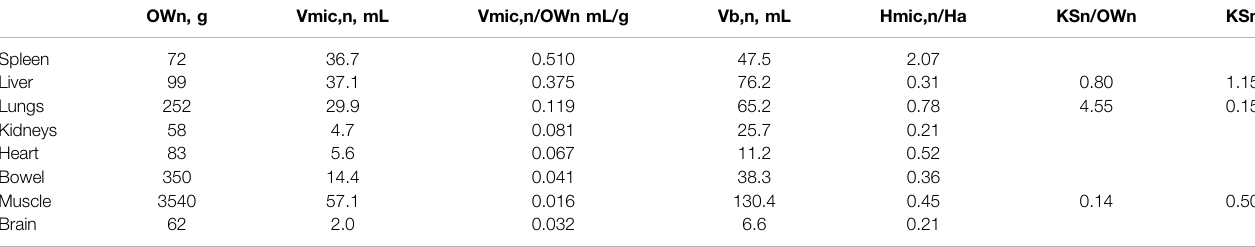
TABLE 2 | Organ weights, volumes of minute vessels, microvascular hematocrit, and the organ KSn product of a normal dog a . OWn,